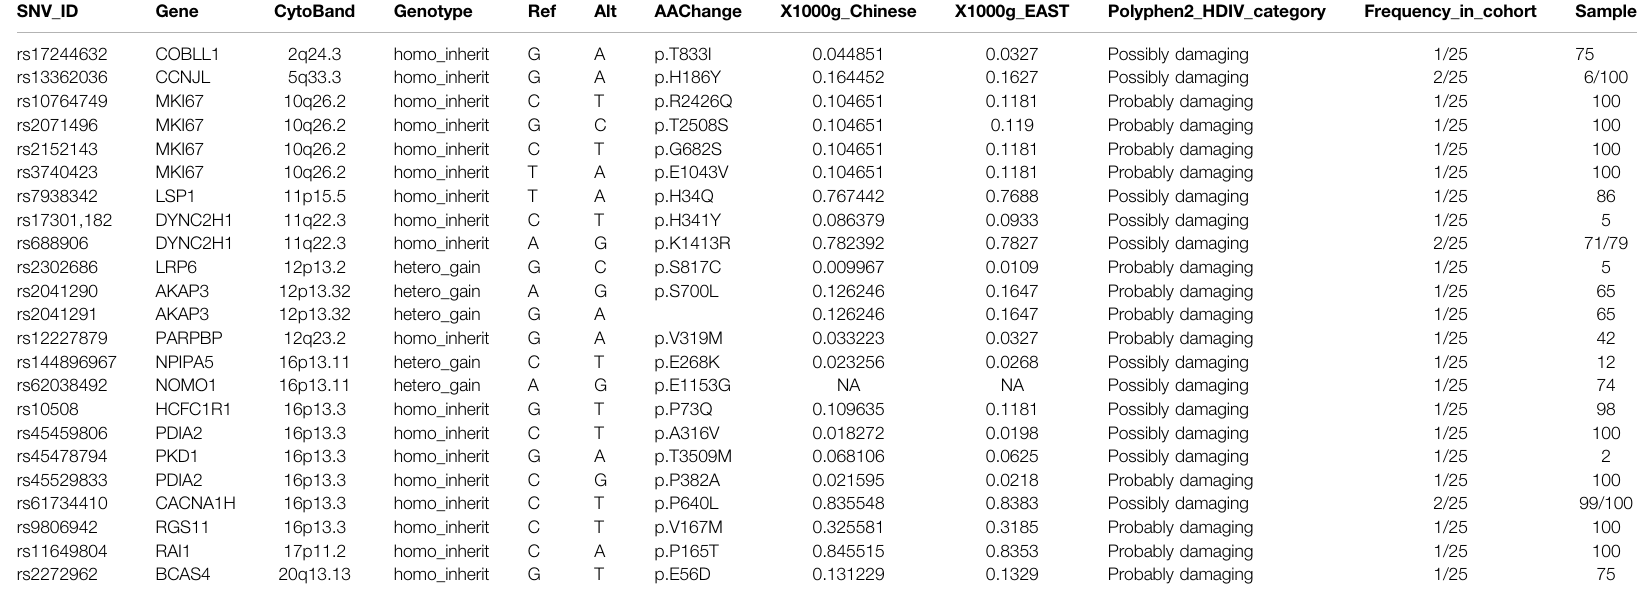
TABLE 1 | Information of fi ltered SNVs in the coding region of genes in reported ADHD-susceptible